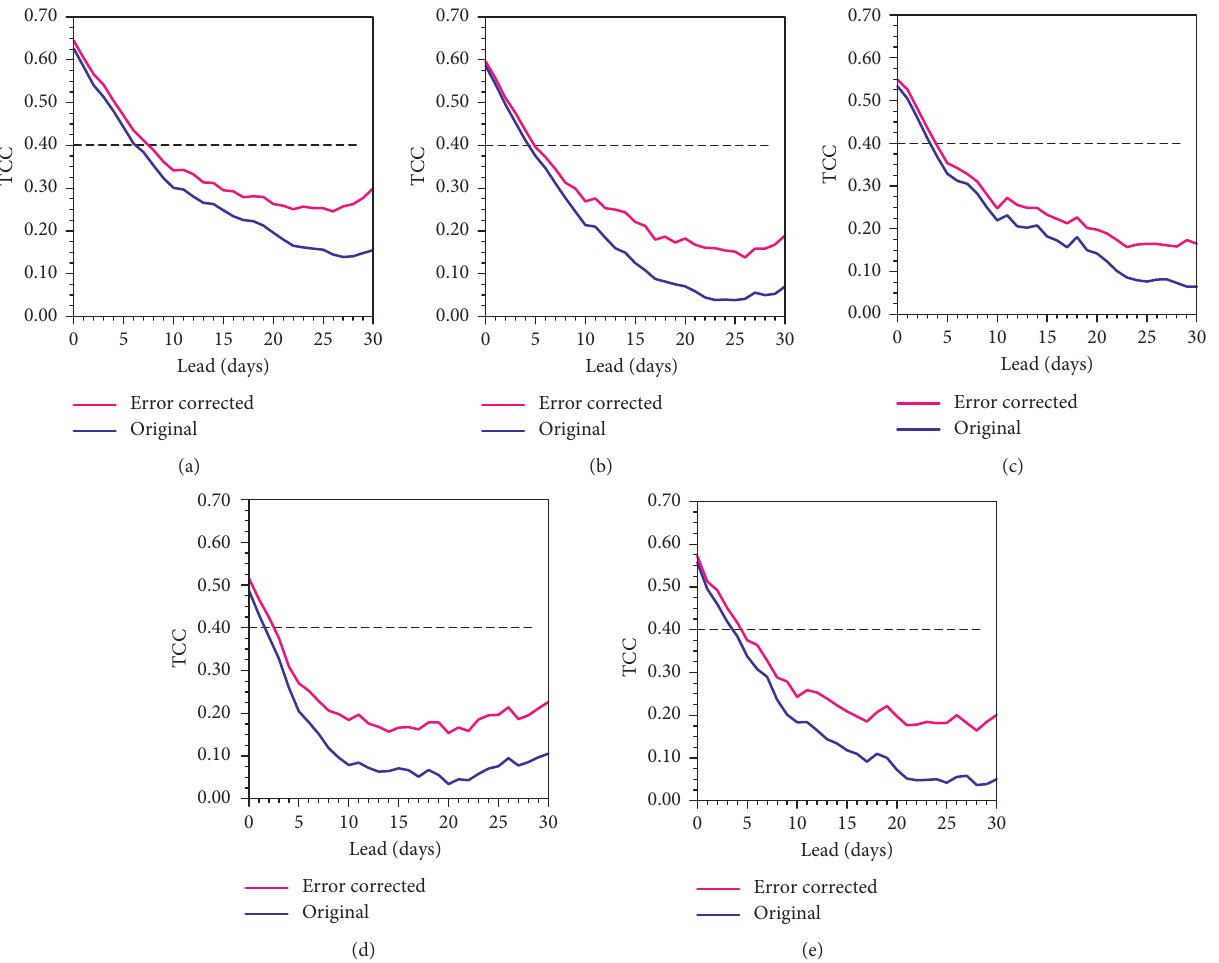
Figure 8: The TCC between the ensemble mean and observed summer accumulated ten-day precipitation for error-uncorrected and error- corrected ECMWF S2S hindcast experiment changing with the lead time (0–30 days) in five subregions of eastern China (a–e) during 1995–2014. The black dashed line is 95% confidence level of TCC. (a) Reg1, (b) Reg2, (c) Reg3, (d) Reg4, and (e)